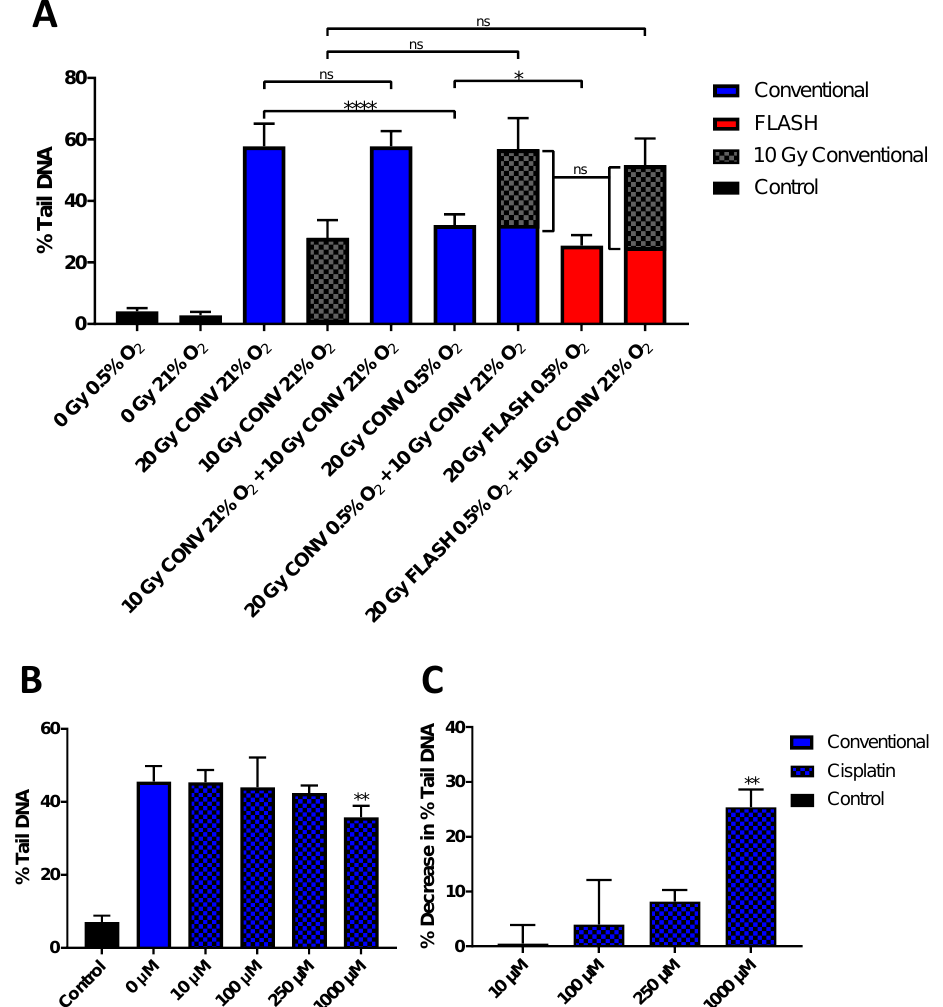
Figure 1. ( A ) Alkaline Comet assay measures of DNA damage formation (% Tail DNA) in whole-blood peripheral blood lymphocytes (WB-PBL) following either 20, 10, or 2 × 10 Gy